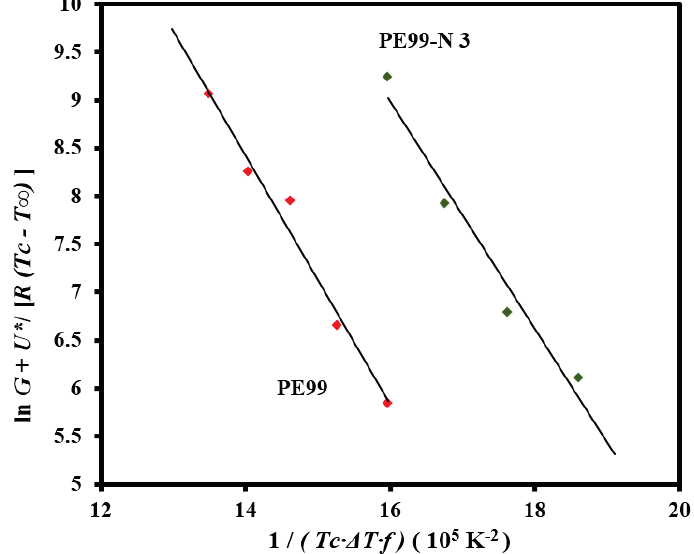
Figure 15. Plot of ln G + U */ R ( T c − T ∞ ) versus 1/ T c ( ∆ T ) f to determine the K g secondary nucleation parameter of PE99 ( garnet ) and PE99-N 3 ( blue )